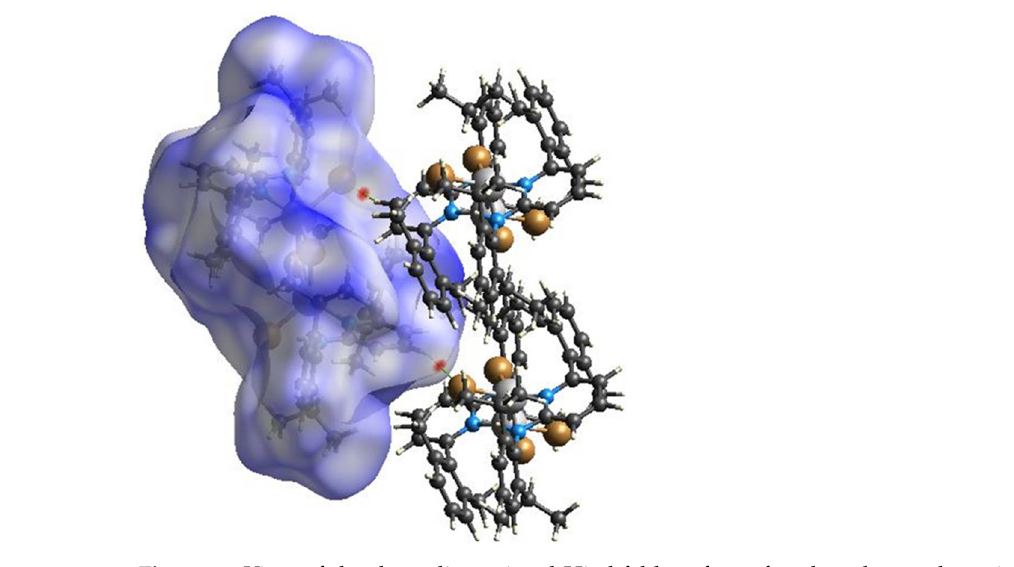
Figure 3. View of the three-dimensional Hirshfeld surface of 1 plotted over d norm in the range −0.0639 to 1.8424.